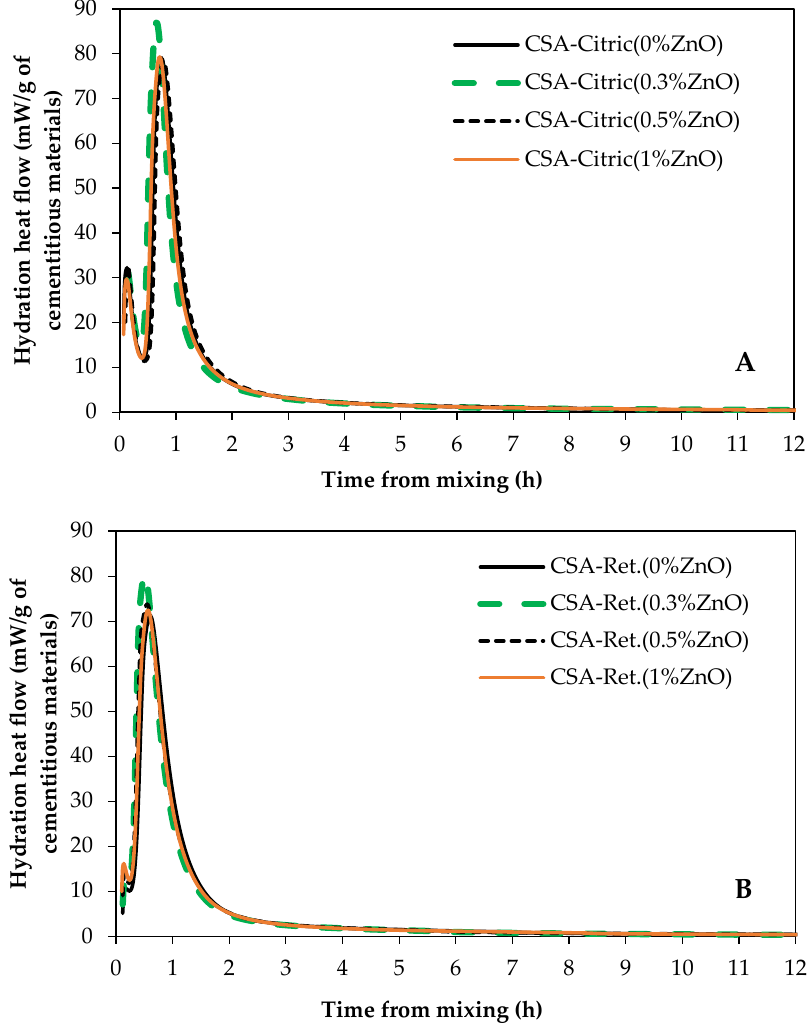
Figure 10. Hydration heat of CSA paste samples; ( A ) dosed by citric acid and ( B ) dosed by a chemical retarder admixture .